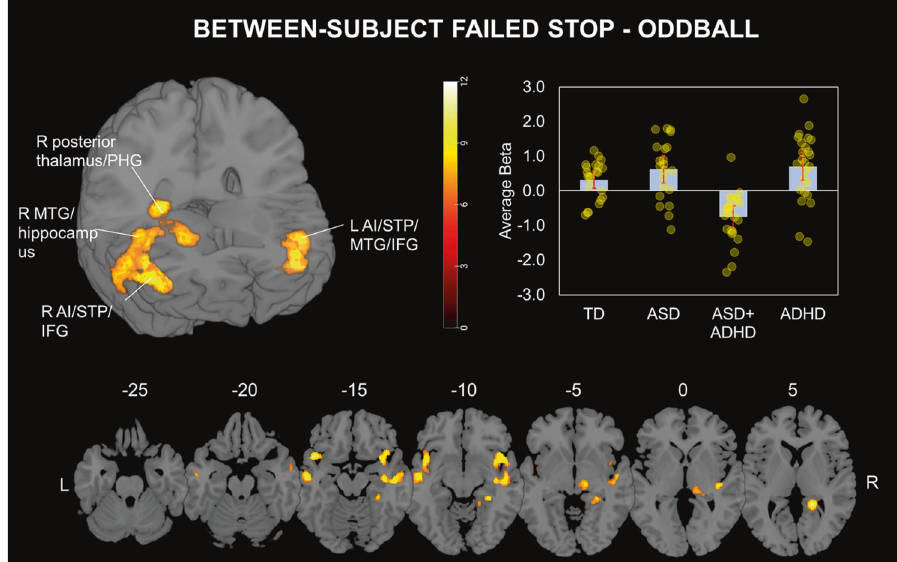
Fig. 2 Whole-brain between-subject clusters of activation during Failed Stop relative to Oddball trials. Activation clusters were found during Failed Stop relative to Oddball trials in left anterior insula (AI)/superior temporal pole (STP)/middle temporal gyrus (MTG)/interior frontal gyrus (IFG); right posterior thalamus/parahippocampal gyrus (PHG); right MTG/hippocampus; and right AI/STP/IFG. Brain activation in the left AI/STP/MTG/IFG is presented in the bar chart across groups as an example, accompanied by error bars representing 95% con fi dence intervals in red and jittered scatterplots of individual activation in yellow. Activation clusters were formed using a peak voxel threshold of p < 0.001, uncorrected, and a cluster extent threshold of p < 0.05 family wise error-corrected for multiple